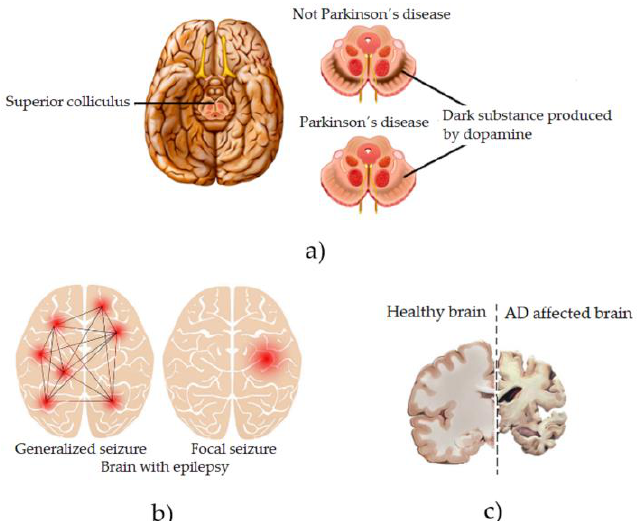
Figure 1. Graphic representation of the effects on the brain of some NDDs. ( a ) Parkinson´s disease, ( b ) Epilepsy and ( c ) Alzheimer disease.